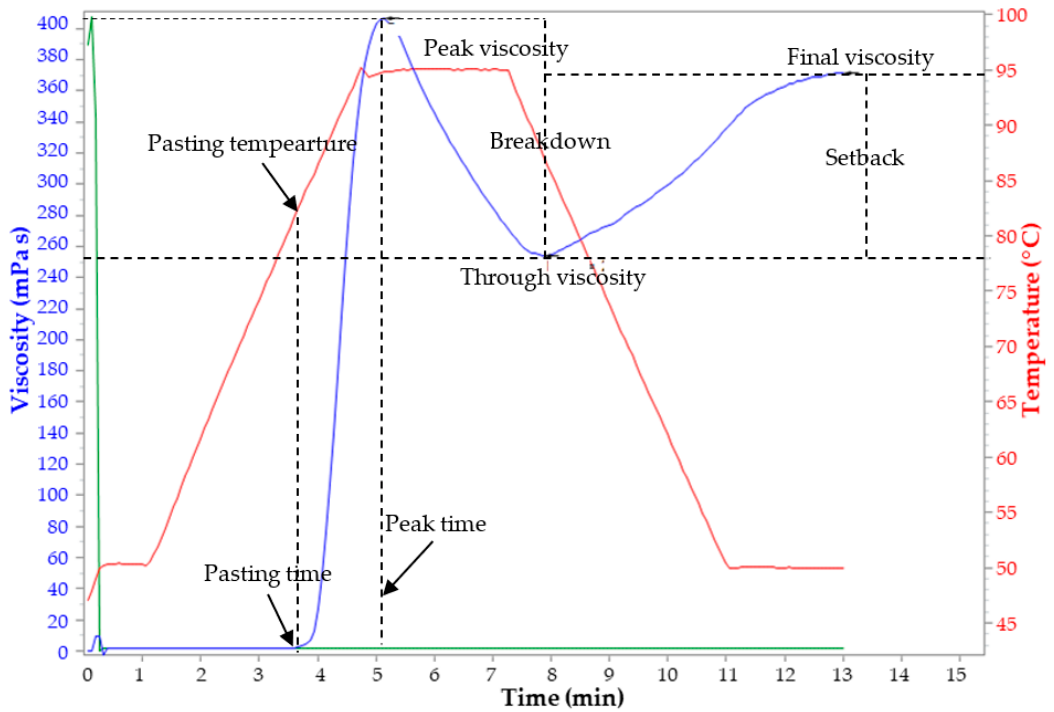
Figure 2. Pasting properties of plantain flour.